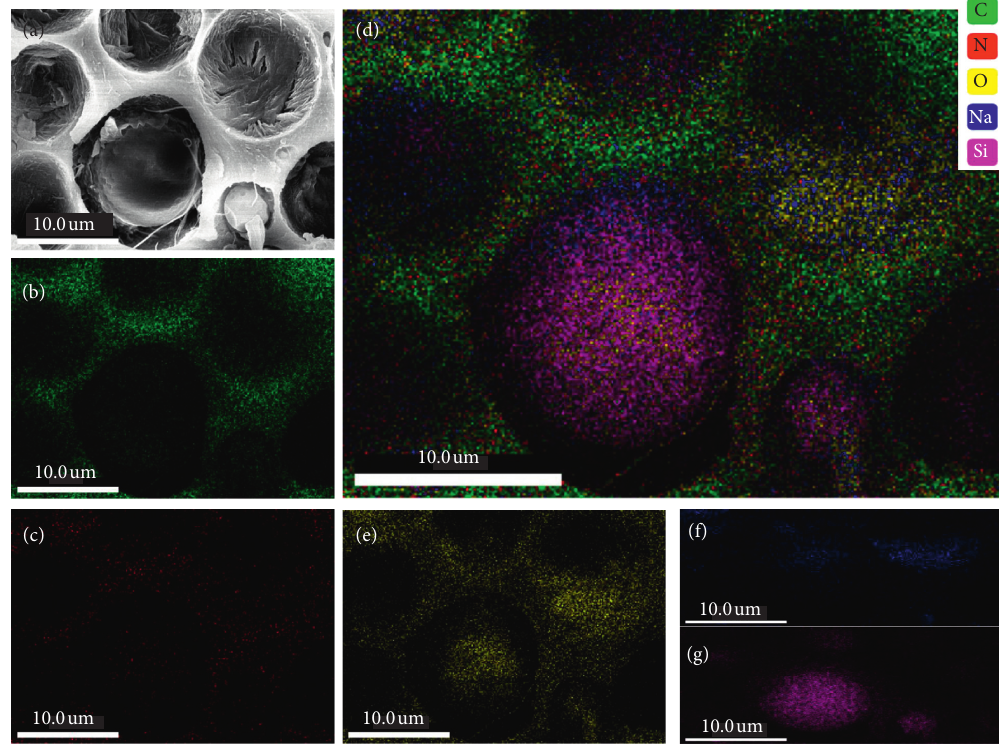
Figure 6: Element distribution of the C7-1% sample.